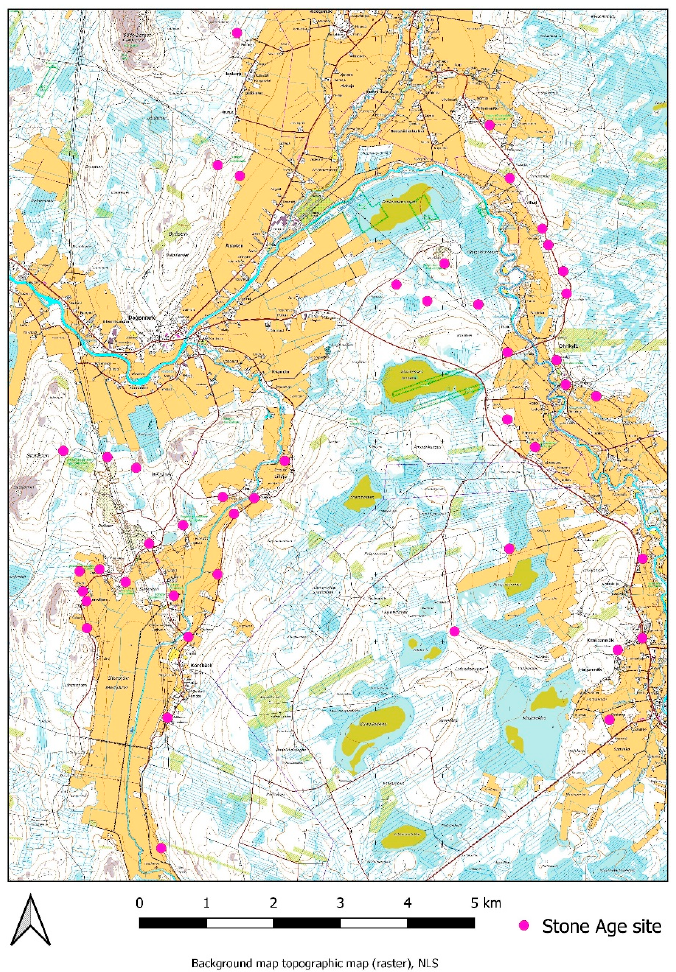
Figure 11. The locations of sites that have been defined as Stone Age in the Kristiinankaupunki area. Grey areas in the background of the map are rocky areas, while the yellow areas are cultivated fields, and the light green or empty white areas in between are forests.